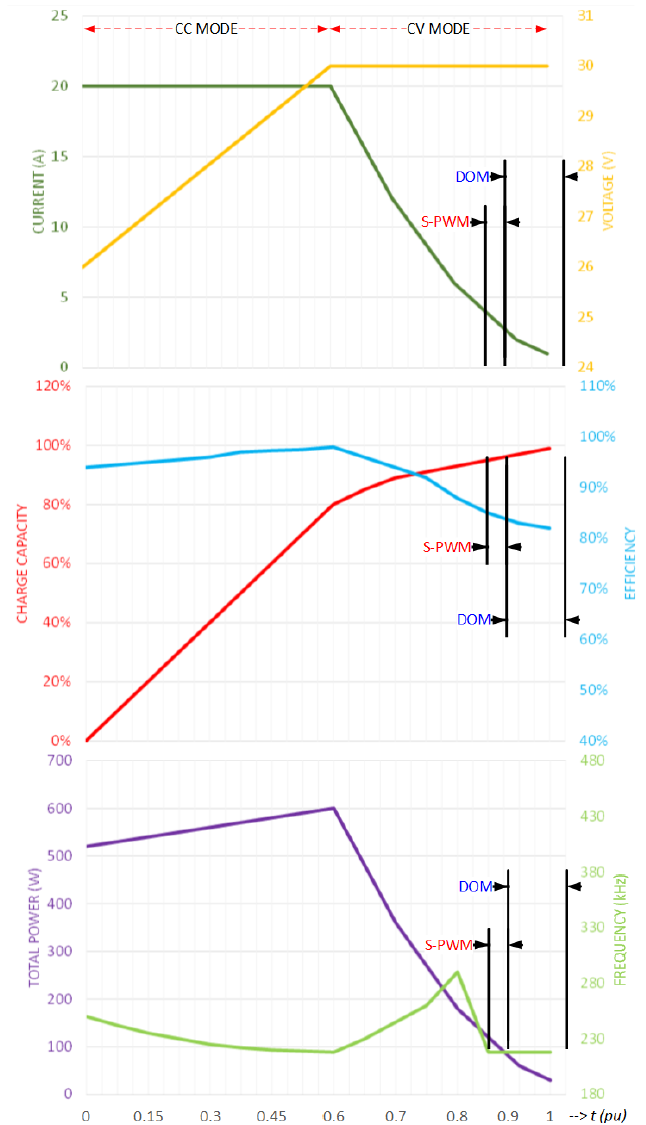
Figure 19. Battery charge profile of LLC resonant converter with addition of the S-PWM and